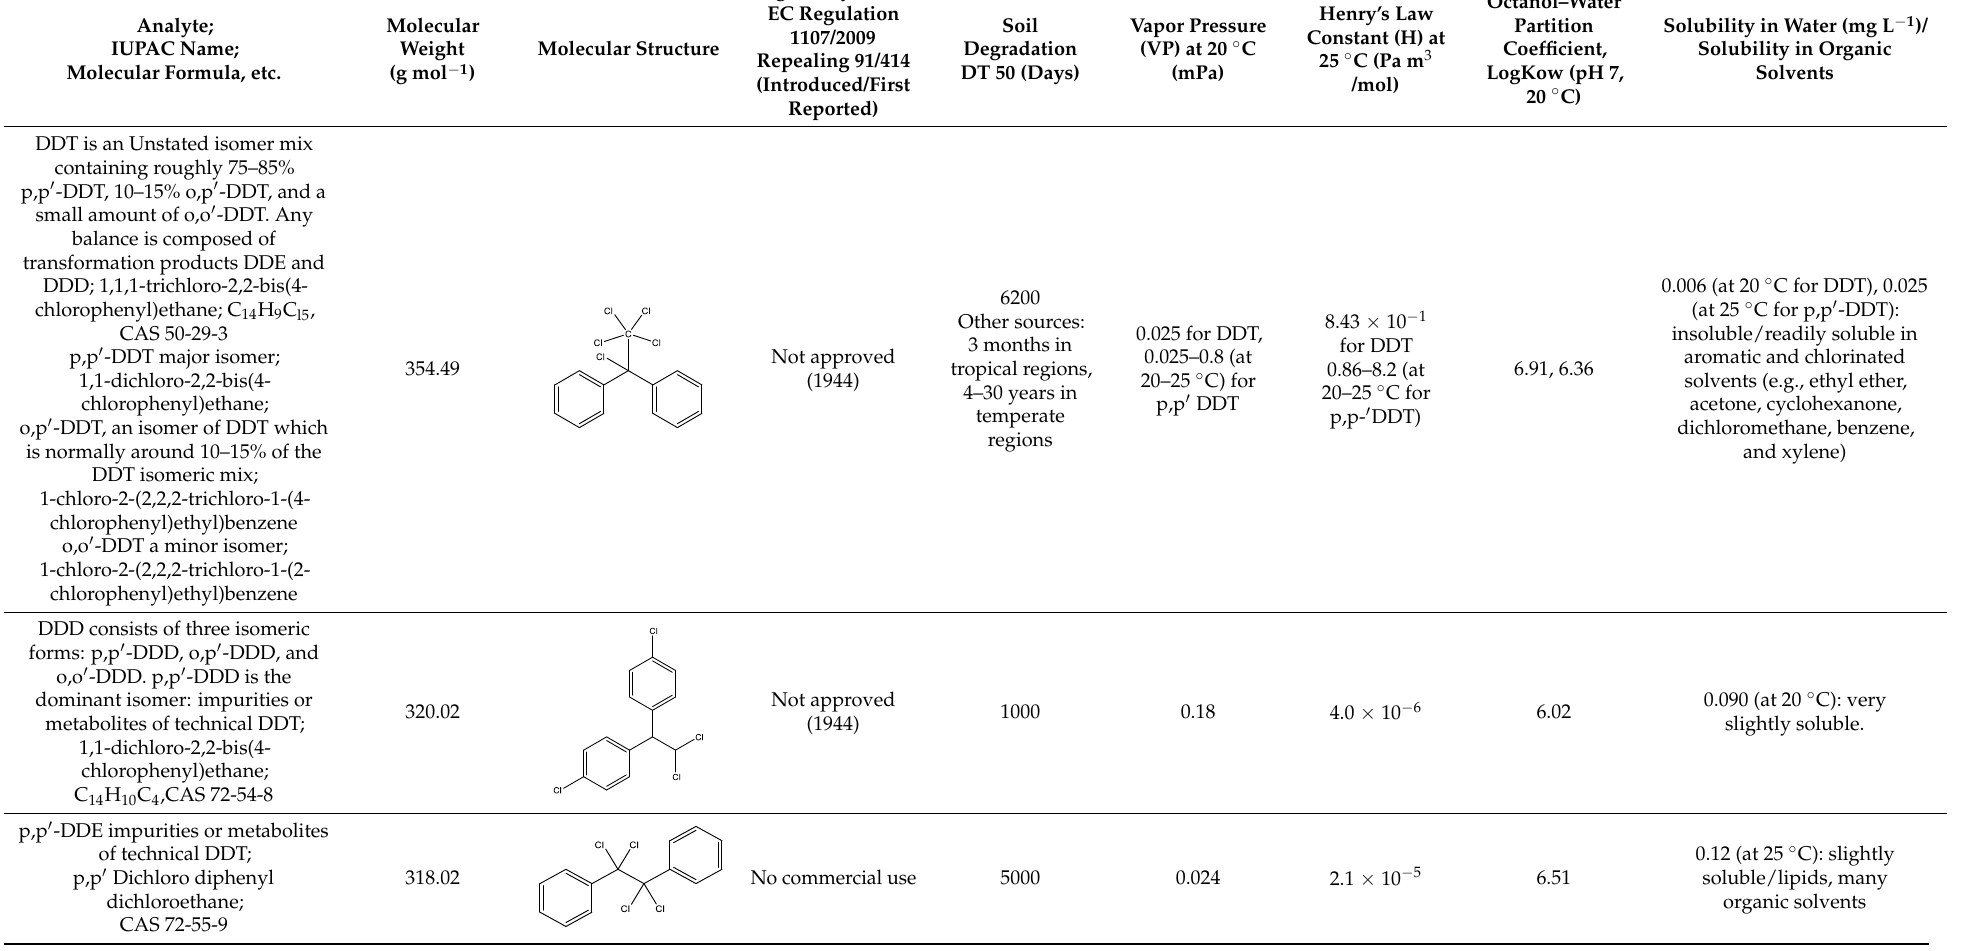
Table 1. * Chemical and physical chlorinated pesticide compounds (OCPs) belonging to insecticide pesticide type and their physicochemical properties. Analyte; IUPAC Name; Molecular Formula, etc.